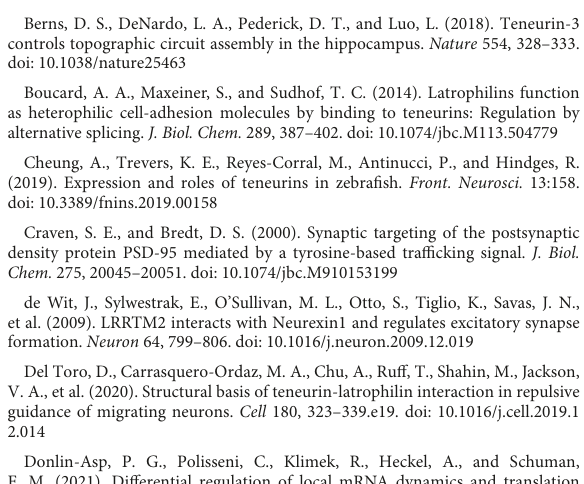
(a) . Scale bar, 5 µ m. (c) Dendritic segment stained for bassoon. (d) Dendritic segment stained for synapsin I. (e) Colocalisation between bassoon and synapsin I after image analysis. (f) ROIs around bassoon puncta after image analysis. (g) Binary image of synapsin I puncta after image analysis. (h) Control colocalisation between bassoon and synapsin I after 90 ◦ rotation of the bassoon image channel (c,f) . (i) ROIs around bassoon puncta after image channel was rotated 90 ◦ . (j) Binary image of synapsin I puncta after image analysis. (k) Co-localisation between bassoon and synapsin I (black) and synapsin I and bassoon-control (grey), ∗∗∗∗ p < 0.0001. (l) Proportion of bassoon clusters (black) and bassoon-control clusters (grey) co-localised with synapsin I per neuron, ∗∗ p = 0.0079. SUPPLEMENTARYFIGURE4 Histogram of basal (blue) and apical (red) spine Tenm3 intensity, where Tenm3 intensity is determined as the ratio Tenm3/GFP intensity. The dotted black line indicates the threshold, which spines are considered to express Tenm3 (1.531). Signal in spines below this threshold was considered to be background (calculated using the mean ration of intensity throughout the dendrite versus spine structures). This data indicates that that only a subpopulation of 17.34% of all basal spines and 25.5% of all apical spines are Tenm3-positive. When apical and basal spines are pooled together, the total proportion of Tenm3-positive CA1 spines amounted to 19.87%. SUPPLEMENTARYFIGURE5 Tenm3 localisation and analysis in dendritic SAPs of CA1 neurons. Representative image showing expression of Tenm3 (A) and GFP (B) in a basal dendritic segment. A merged image is shown in (C) , where for every image three ROIs were traced for analysis: spine ROI, SAP ROI, and background ROI. Scale bar, 1 µ m. SUPPLEMENTARYFIGURE6 EGFP-tagged truncated teneurin variants are localised to the cell membrane in N2a cells. EGFP-tagged Tenm3 expression constructs were transfected into N2a cells and imaged 48 h post transfection. Both EGFP-tagged truncated Tenm3 variants could be found expressed at the membrane. Representative images showing Tenm3 (cid:49) ECD_EGFP (A) and Tenm3 (cid:49) ICD_EGFP (B) expression. Scale bar, 20 µ m. SUPPLEMENTARYFIGURE7 Different teneurin paralogues show overlapping expression when expressed together in dissociated neurons. EGFP- and tagRFP-tagged teneurin paralogues co-transfected in primary neuronal cultures have similar patterns of expression and can be found in clusters along neurites. Scale bar, 20 µ